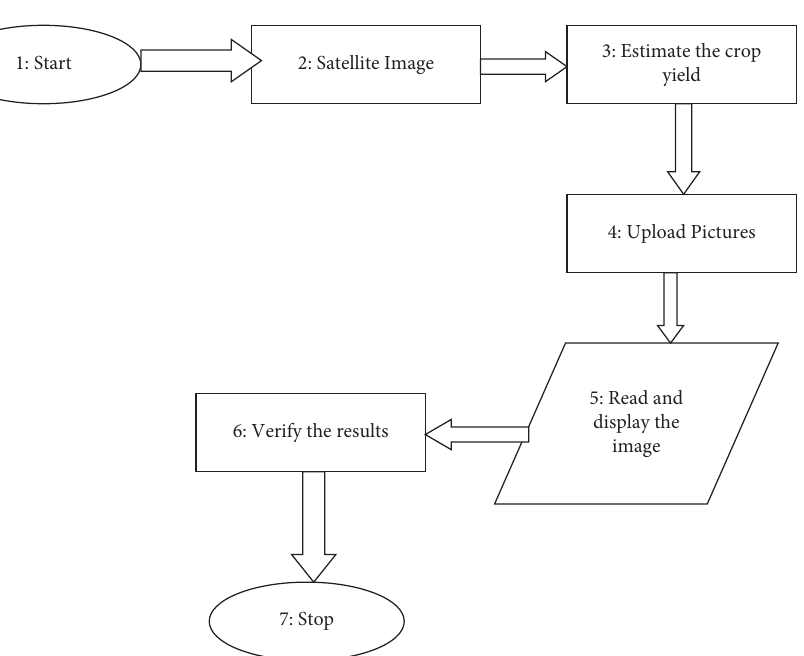
Figure 3: Crop production estimation using an intelligent system.